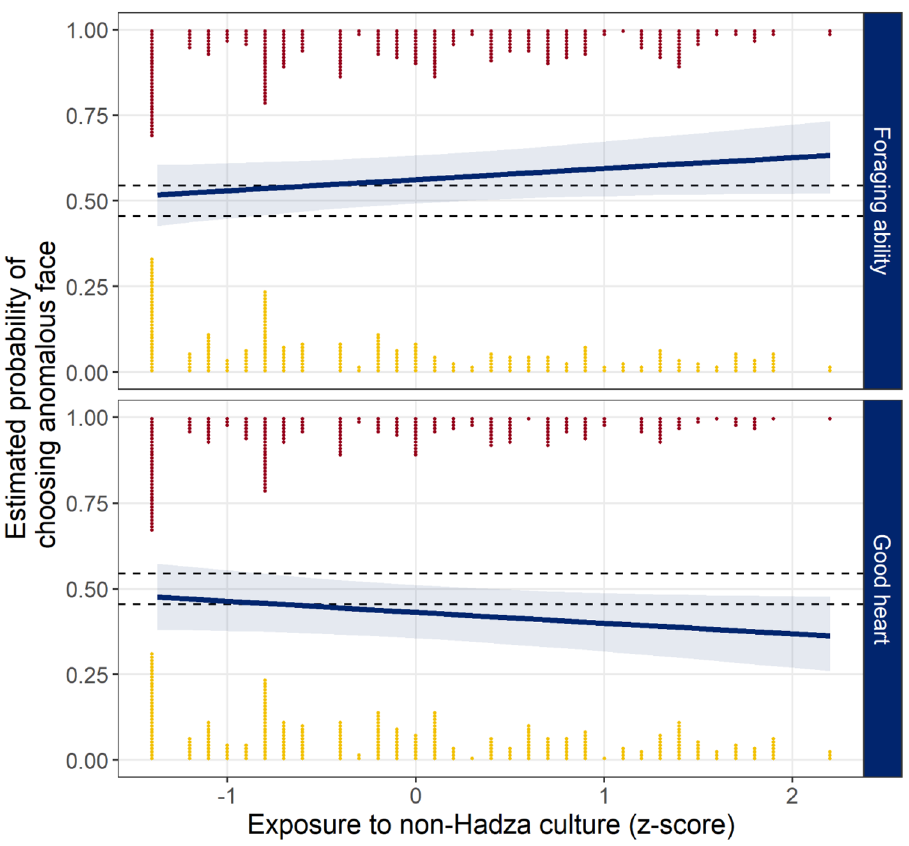
Figure 2. Joint posterior predictions by participants’ exposure to non-Hadza culture as a z -score and trait being evaluated. Lines are the median estimate from the posterior and shaded regions are the 90% highest density intervals (HDI). Points are individual responses (for plotting, exposure values were rounded to the nearest tenth), with red points at the top indicating when the participant chose the anomalous face, and the yellow points at the bottom indicating when the participant chose the non-anomalous face. Dashed lines indicate the region of practical equivalence